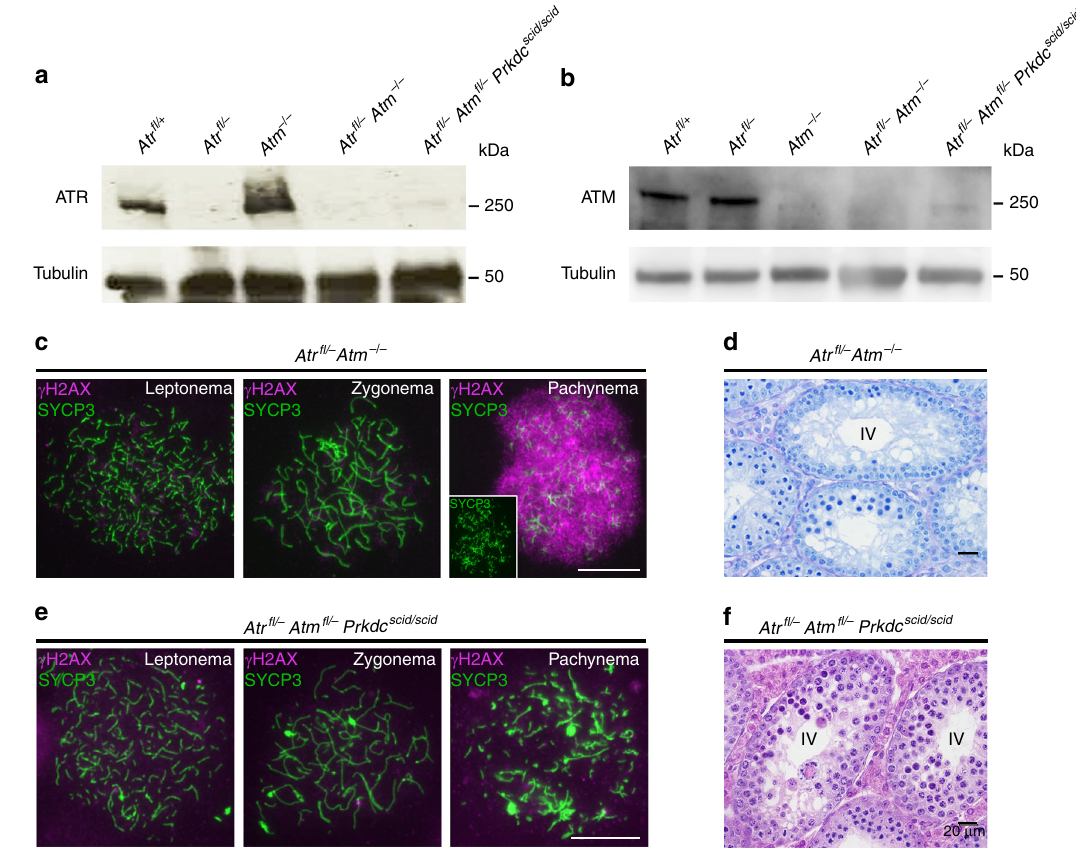
Fig. 2 Mid-pachytene germ cell elimination is preserved in mice de fi cient in the PIKKs. Western blot showing a ATR and b ATM depletion in mice with different PIKK mutations. c γ H2AX (magenta) and SYCP3 (green) immunostaining ( n = 2 males, 25 cells for each stage) and d stage IV elimination in Atr fl / – Atm − / − males. e γ H2AX and SYCP3 immunostaining ( n = 2 males, 25 cells for each stage) and f stage IV elimination in Atr fl / – Atm fl / – Prkdc scid/scid males. Scale bar 20 µ m in d , f and 10 µ m in c ,